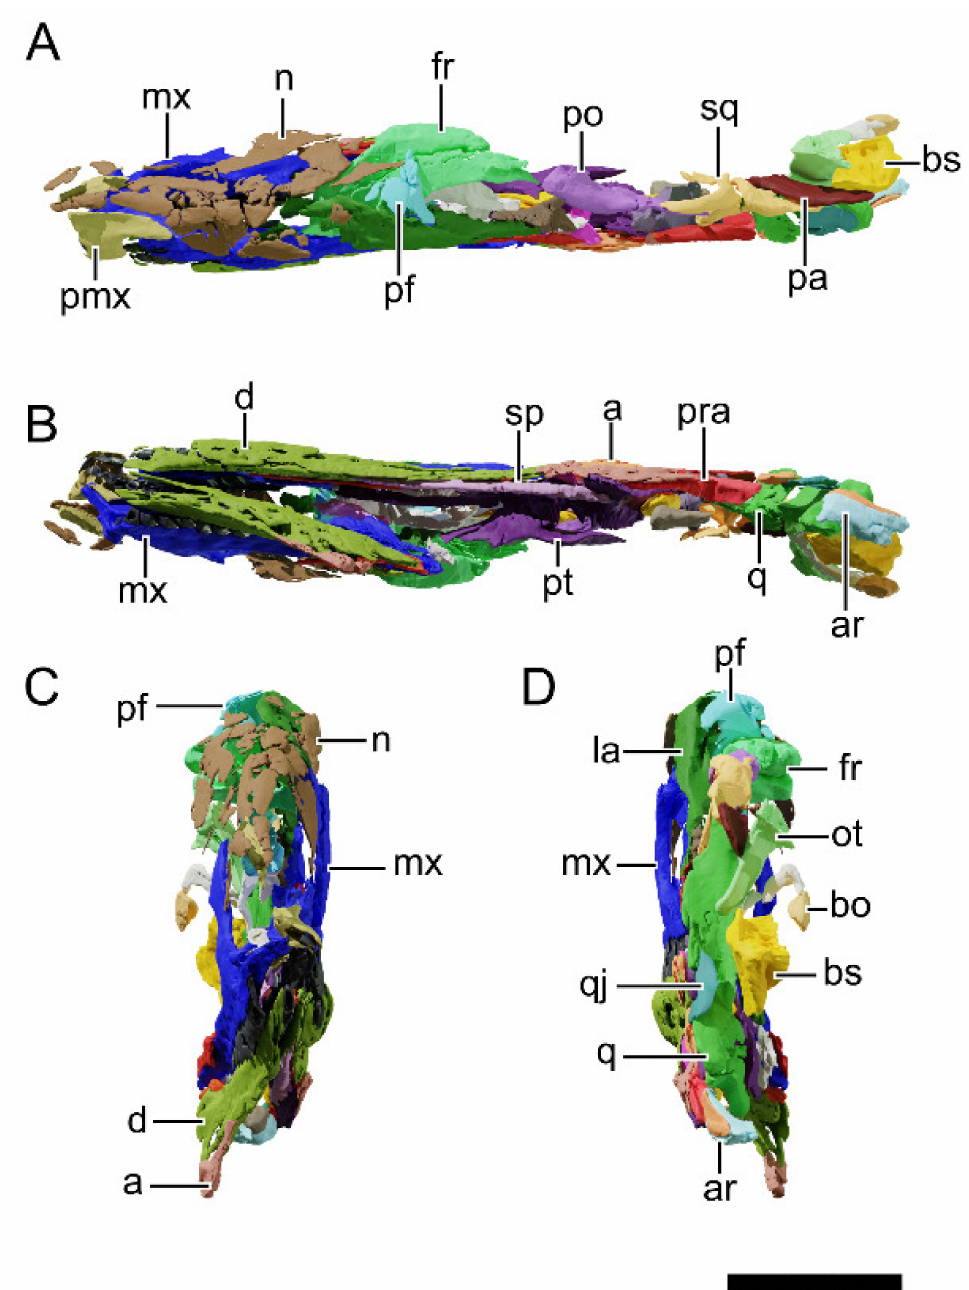
Figure 5. Digital reconstruction of the skull of NHMD 164741. ( A ) Dorsal view. ( B ) Ventral view. ( C ) Anterior view. ( D ) Posterior view. Abbreviations: a, angular; ar, articular; bo, basioccipital; bs, basisphenoid; d, dentary; fr, frontal; la, lacrimal; ls, laterosphenoid; mx, maxilla; n, nasal; ot, otoccipital; pa, parietal; pf, prefrontal; pmx, premaxilla; po, postorbital; pra, prearticular; pt, pterygoid; q, quadrate; qj, quadratojugal; sa, surangular; sp, splenial; sq, squamosal. Scale bar = 50